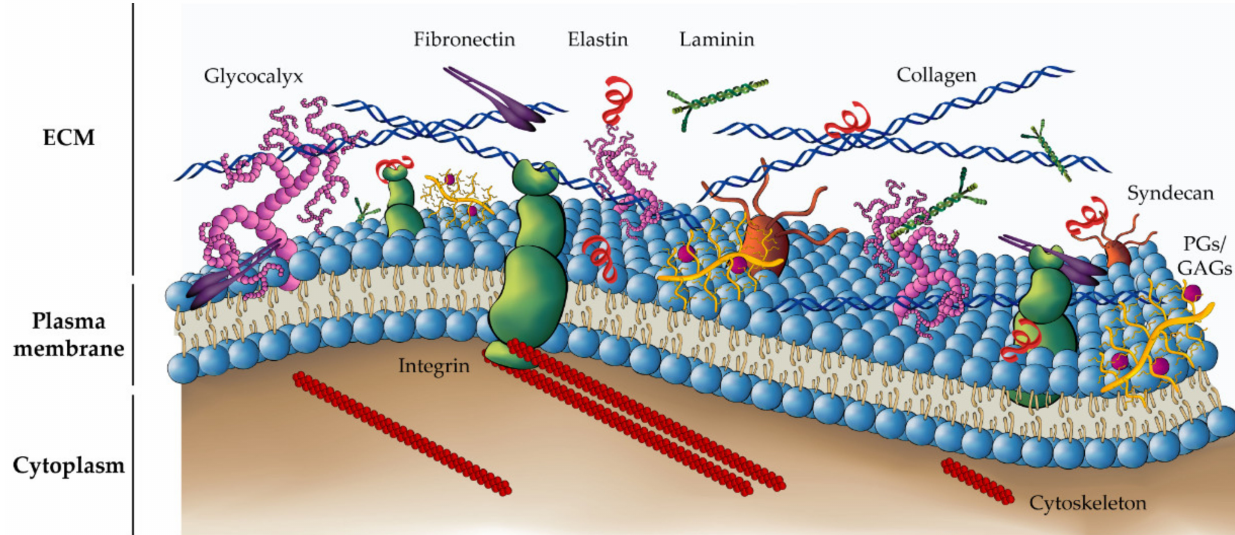
Figure 1. Extracellular matrix (ECM) composition and functions. The ECM is a non-cellular three-dimensional structure made of a large number of cell-secreted macromolecules that provide structural and biochemical support to surrounding cells. Structurally, ECM can be briefly summarized as a blend of water, fibrous proteins, and polysaccharides, e.g., proteoglycans (PGs) and glycosaminoglycans (GAGs). Collagen is the main structural component of the ECM that provides tensile strength to tissues, regulates cell adhesion by anchoring to integrins, and triggers cell differentiation and survival cues. Besides, the collagen lattice interacts with other non-collagenous glycoproteins, e.g., fibronectin, laminin, or elastin- favoring the reinforcement and spatial organization of the ECM. Fibronectin and laminin fibers play a pivotal role in ECM assembly, acting as “adhesive” proteins. Namely, these proteins allow the simultaneous binding to cell-surface receptors, e.g., integrins and syndecans or the cortical glycocalyx-, fibrillar proteins, and other focal adhesion molecules via multiple domains interspersed throughout their structure, which in turn influences cell proliferation, differentiation, and motility. Elastin fibers provide mechanical resilience and elasticity to tissues. Therefore, the collagen/fibronectin ratio confers unique mechanical properties to the tissues that allow both reversible extensibility behavior and the strength to bearing forces. On the other hand, PGs and GAGs fill the interstitial spaces forming a highly hydrated gel by sequestering water molecules, providing compressive strength and buffering properties to tissues. Furthermore, GAGs are a reservoir of growth factors, e.g., TGF- β , EGF, PDGF, etc., that trigger a wide range of fundamental physiological processes ranging from cell proliferation and differentiation to cell adhesion and motility. Indeed, GAGs also modulate cell behavior by interacting with cell-surface receptors to induce cytoskeleton-mediated mechanotransduction of signals and subsequent gene